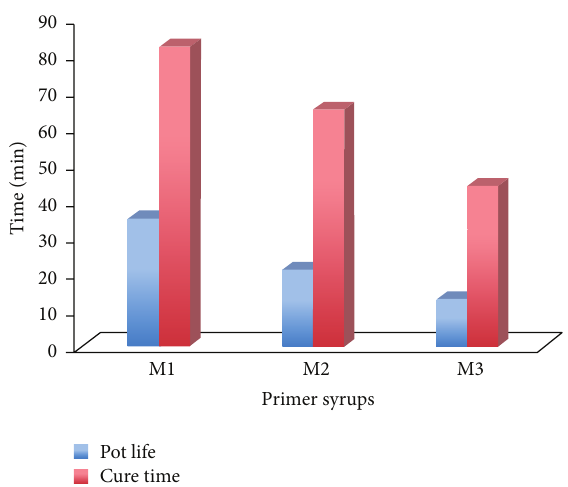
Figure 7: Pot life and cure time of primer syrup in presence of BPO and NDPT.